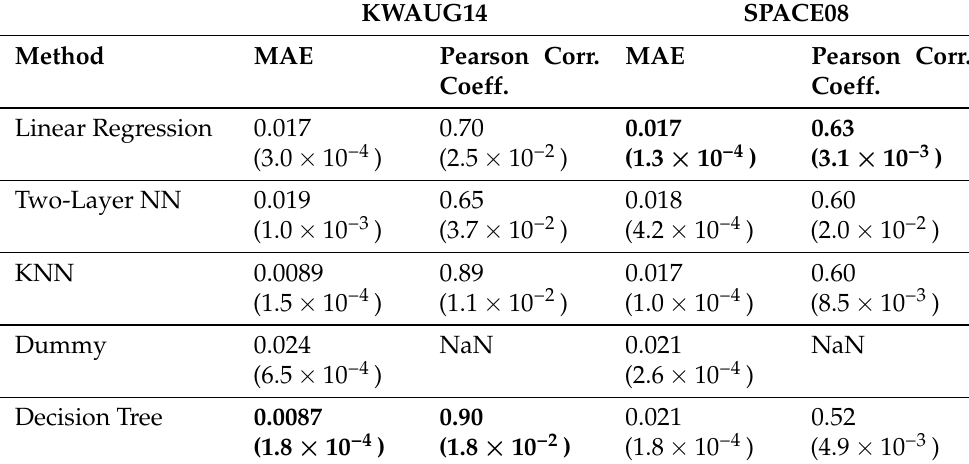
Table 1. Conventional regression results using traditionally available